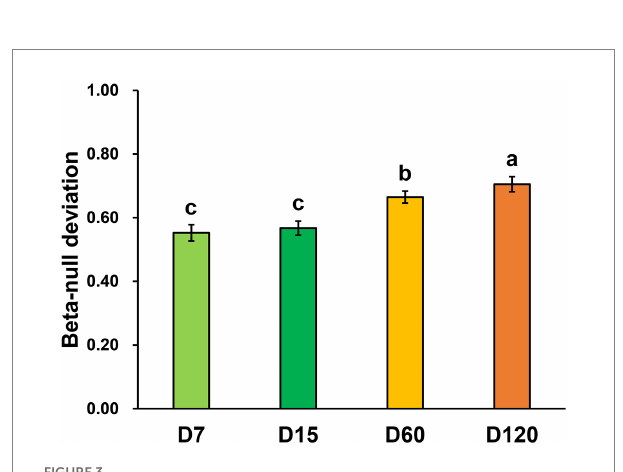
FIGURE 3 Abundance-based beta-null deviation for bacterial communities based on the Bray–Curtis distance. Different letters indicate significant differences as checked by the Kruskal-Wallis rank sum test ( p <